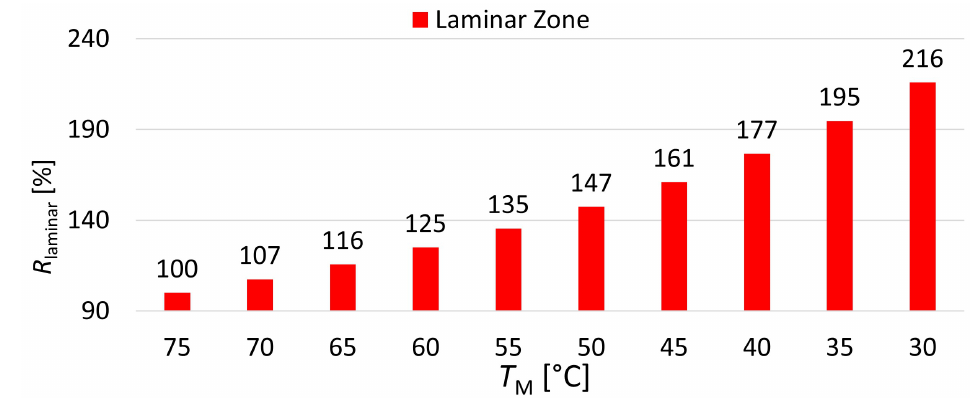
Figure 2. Relative pressure drop R for different mean heating element temperatures T